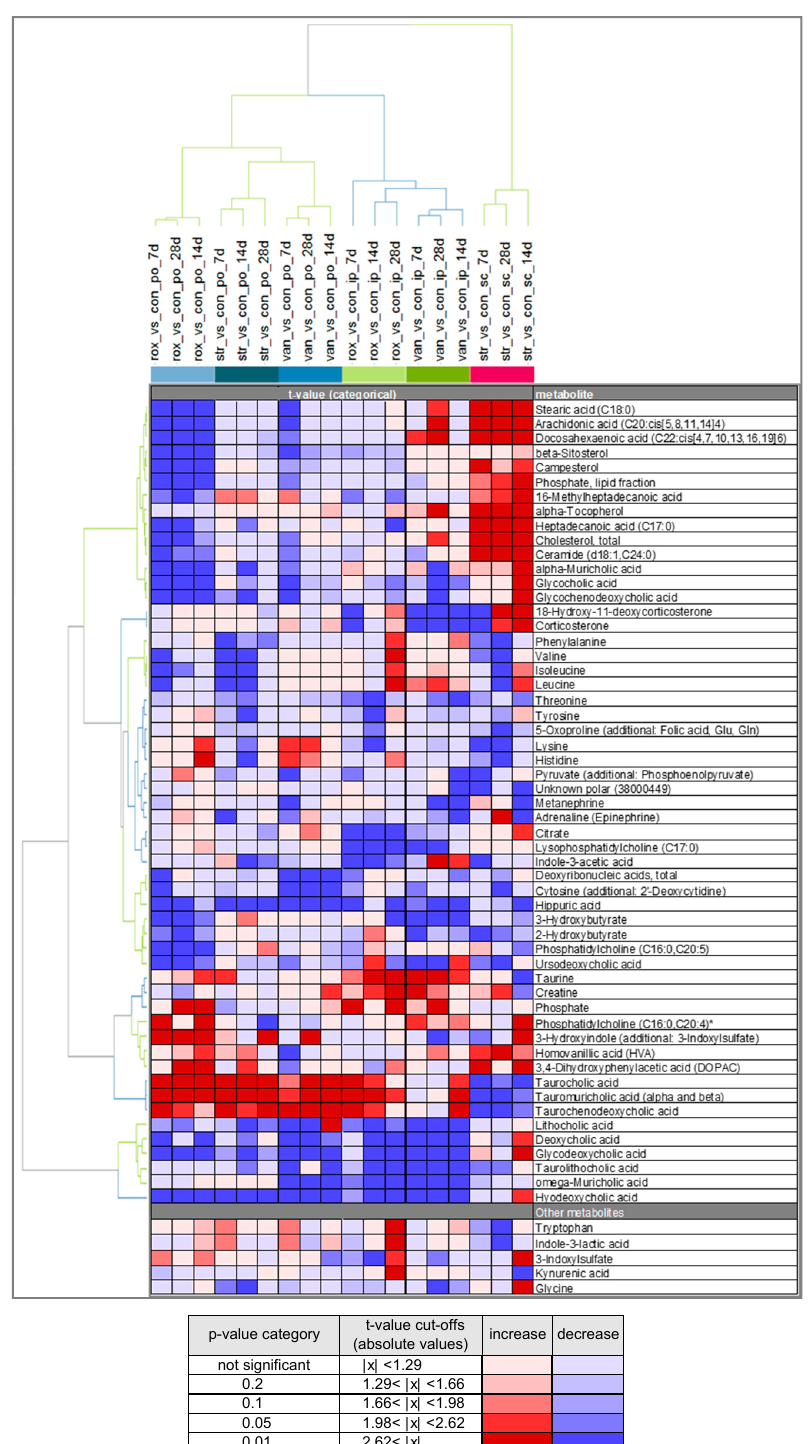
Figure 3. Hierarchical clustering analysis (HCA) of plasma metabolic profiles of antibiotic-treated male Crl/Wi(Han) rats compared to vehicle control animals. Animals were orally or parenterally dosed with roxithromycin, streptomycin or vancomycin for 28 days daily. Plasma samples were drawn on days 7, 14 and 28 (indicated by 7d, 14d, 28d). Coloring is based on the t-values. Input values are normalized against the respective vehicle control, and depicted in the axis label as antibiotic_vs_vehicle control_study day. rox, roxithromycin; str, streptomycin; van, vancomycin; con_po, per os vehicle control; con_ip, intraperitoneal vehicle control; con_sc, subcutaneous vehicle control. * additional: phosphatidylcholine (C18:2,C18:2).